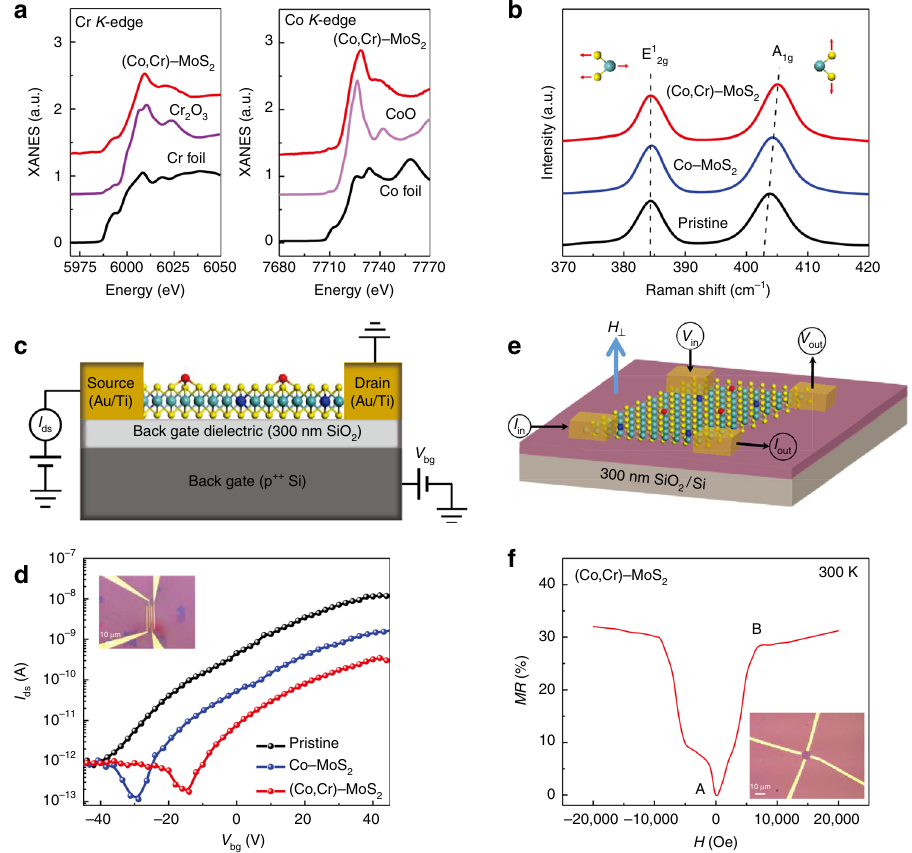
Fig. 4 The effect of incorporating alien TM atoms into MoS 2 monolayer. a Co and Cr K -edge XANES spectra of (Co, Cr)-MoS 2 monolayer and Cr foil, Cr 2 O 3 , Co foil, CoO. b Raman spectra of pristine monolayer MoS 2 , Co – MoS 2 , and (Co, Cr)-MoS 2 . c Schematic illustration of the back-gate FET device. d Drain – source current ( I ds ) versus gate voltage ( V bg ) transfer characteristics at V ds = 1 V. e Schematic illustration of van der Pawl geometry in MR measurement. f Magnetic- fi eld-dependent resistance of (Co, Cr)-MoS 2 at 300 from the interactions between different MoS 2 monolayers (see Supplementary Fig. 14 for the magneto-optical Kerr effect (MOKE) signal). It re fl ects the fact that the FM in a large number of MX 2 fi lms actually comes from the FM of a single layer.